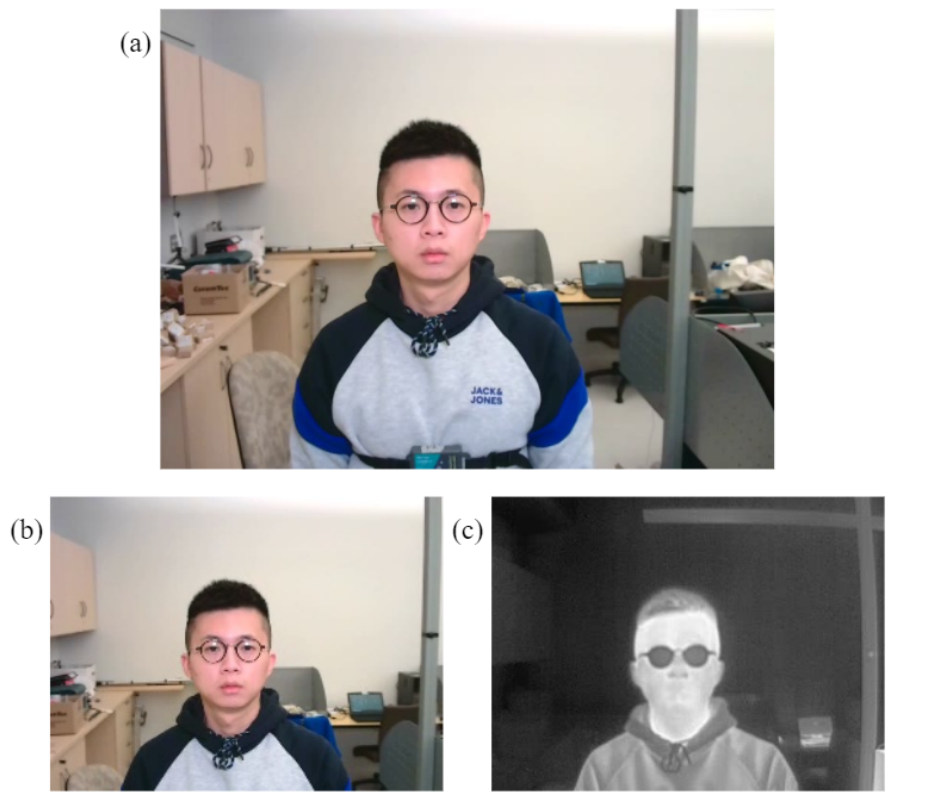
Figure 8. Demonstration of RGB and thermal image alignment, ( a ) original RGB image (640 × 480), ( b ) cropped RGB image (256 × 192), ( c ) aligned thermal image (256 ×